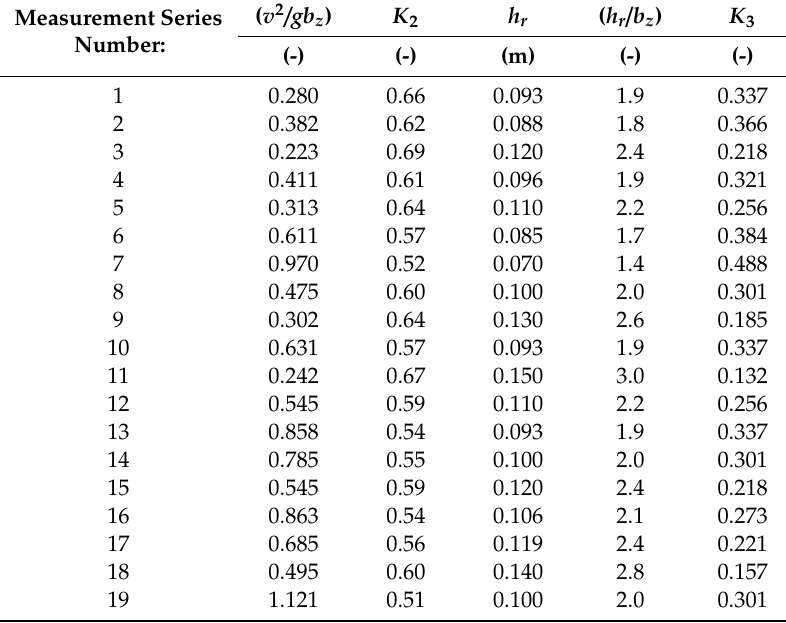
Table 5. Computational parameters of the Equation (6) (in accordance with Journal of Laws of 2000 No. 63, item 735